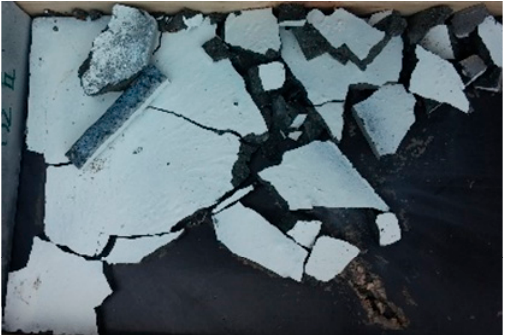
Figure 8. Failure type III. Reprinted/adapted by permission from Springer Nature: Springer Nature Switzerland AG, Mina, A.L.; Trezos, K.G.; Petrou, M.F. Mechanical Properties of Ultra High Perfor-